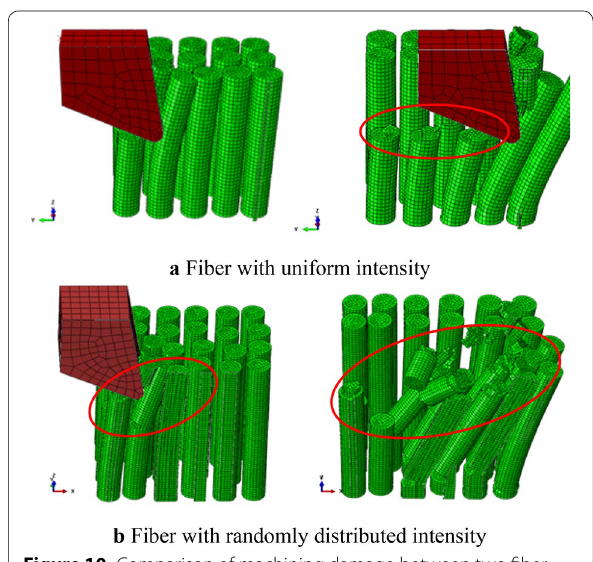
Figure 10 Comparison of machining damage between two fiber